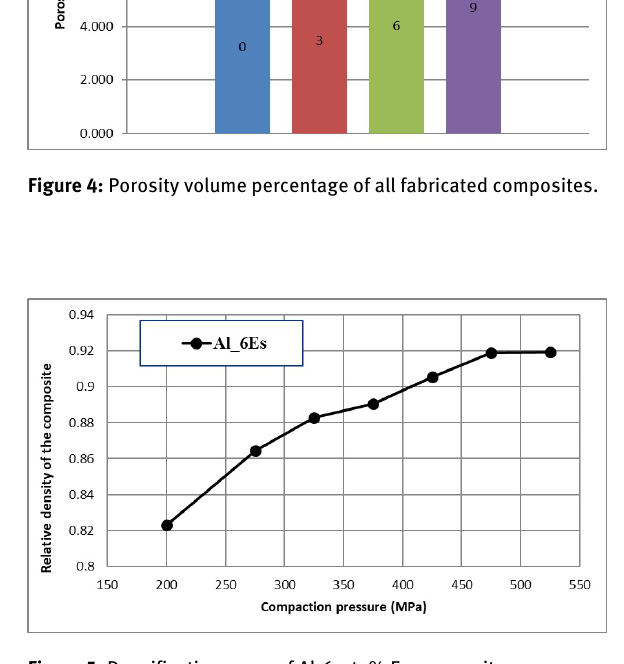
Figure 5: Densification curve of Al-6 wt. % Es composite.